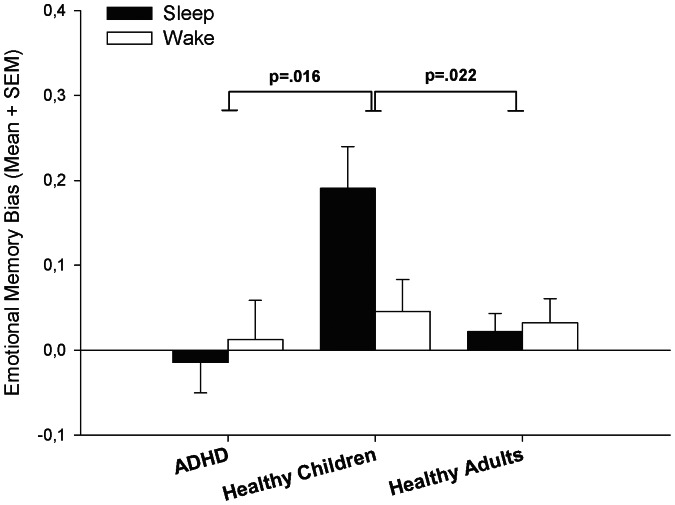
Behavioural performance; emotional memory bias, difference in recognition accuracy between emotional and neutral picture condition; note that all values are baseline-corrected and indicate changes in emotional bias over retention intervals; SEM, standard error of means.